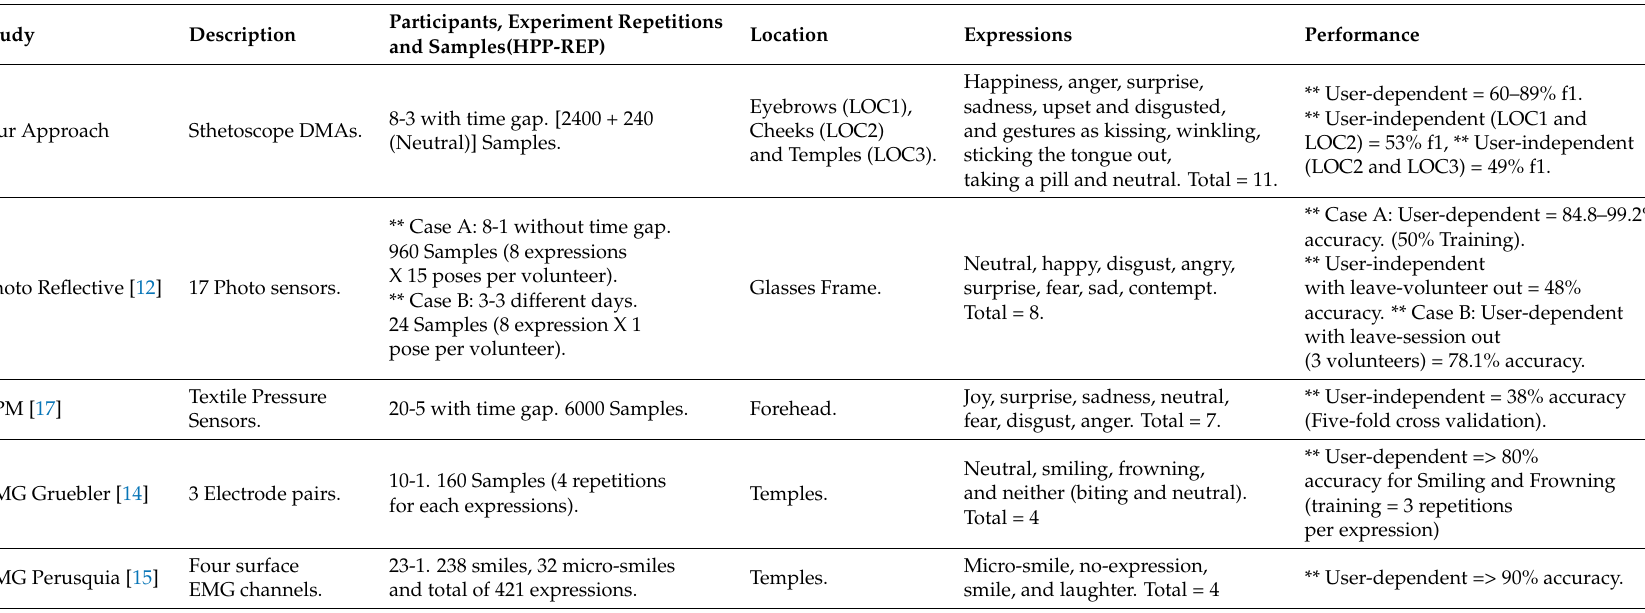
Table 2. Comparison with state-of-the-art non-visual methods for facial expressions recognition. Human Participant Pool (HPP). Repetitions of entire experiment